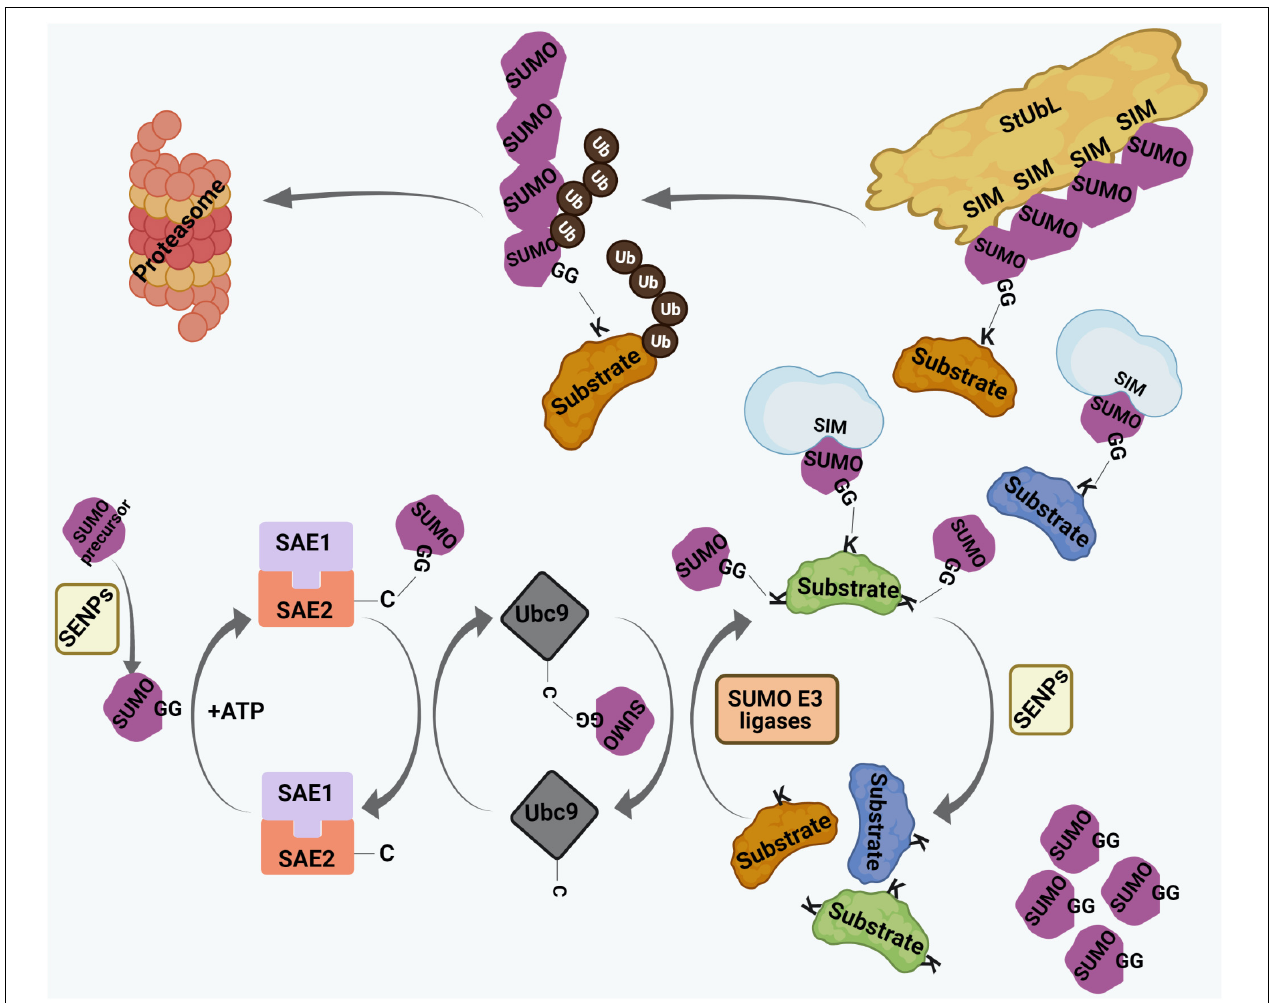
FIGURE 2 | The process of SUMO conjugation and deconjugation. SUMO precursors are proteolytically cleaved by Sentrin-specific proteases (SENPs) to yield conjugation-competent SUMO molecules with terminal di-glycine (GG) motif. SUMO conjugation involves sequential involvement of 3 enzymes – the SUMO E1 activating enzyme (SAE1/SAE2 dimer in human), the SUMO E2 conjugating enzyme (Ubc9 in human), and a limited subset of SUMO E3 ligases. SUMO makes transient, intermediate thioester linkage to cysteine (C) residues of SAE2 and Ubc9 before being finally transferred on to the lysine (K) residues of substrates. The terminally exposed GG of each SUMO forms a covalent isopeptide bond with the ε -amino group on target K residue. Targets can either be monoSUMOylated at single K residue, multi-mono SUMOylated at many K residues or poly-SUMOylated forming SUMO chains. SUMO residues on SUMO-conjugated proteins interact non-covalently with proteins having SUMO interacting motif (SIM). SUMO conjugation can be reversed by SENPs where SUMO residues are cleaved off the substrates. SUMO chains are also targeted by a specific set of E3 ubiquitin ligases, called SUMO targeted ubiquitin ligases (StUbLs), having multiple tandemly arranged SIMs. StUbLs can induce proteolytic/non-proteolytic ubiquitylation of poly-SUMO-primed substrates; the former leads to proteasomal degradation of the